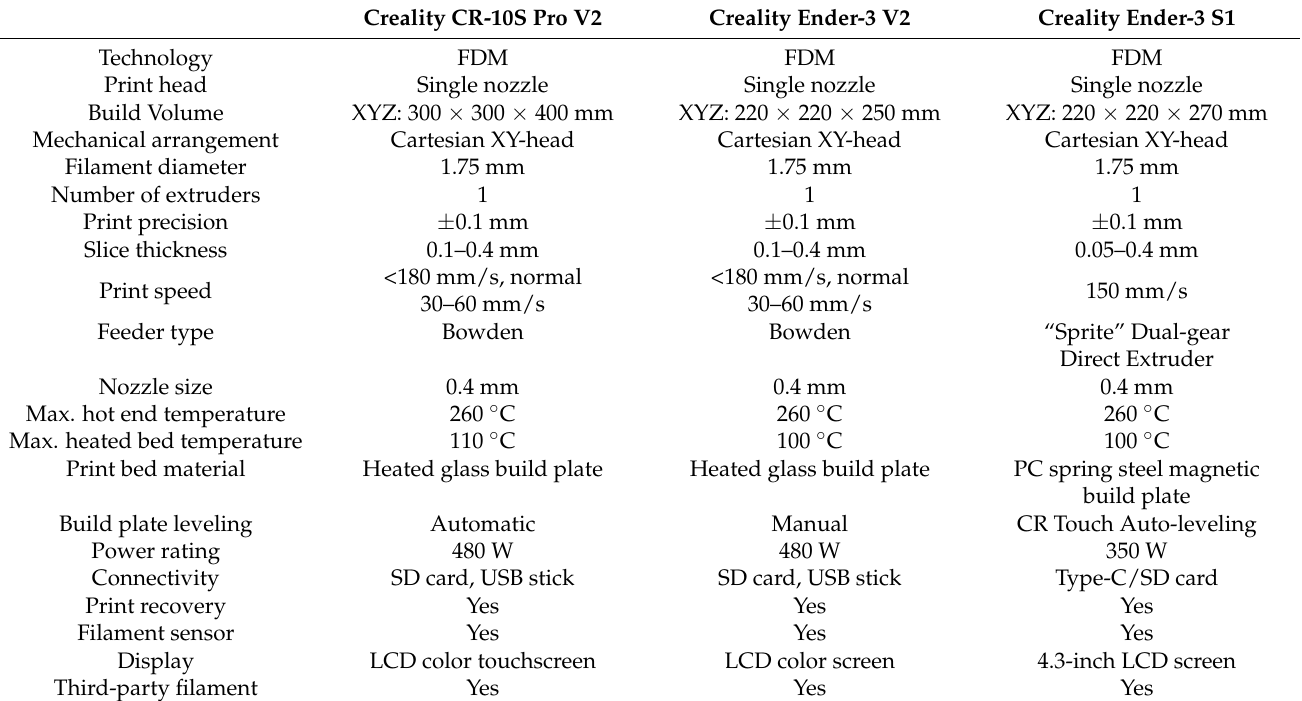
Table 1. Characteristics of the applied Creality 3D